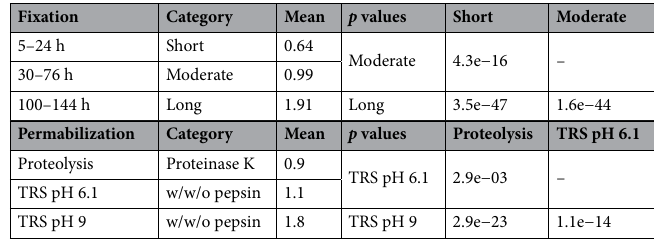
Table 2. Overall result table. The first column to the left presents the fixation time given in hour intervals and permeabilization categories: Proteolysis, Target Retrieval Solution (TRS) pH 6.1 and TRS pH 9. Second column, category of hour interval: short (5–24 h), moderate (30–76 h), long (100–144 h) and category of permeabilization: proteinase K or with (w/) or without (w/o) pepsin. Third column, Mean: the mean of the scores given in each category (Category). The fourth to the sixth column: a pairwise comparison of all categories using a Wilcoxon rank sum test. The fourth column and upper bar of column six and five displays the category to be compared (short, moderate or long). The numbers in column five and six display the p value of the given comparison of the categories. The p values were adjusted using the Benjamini and Hochberg